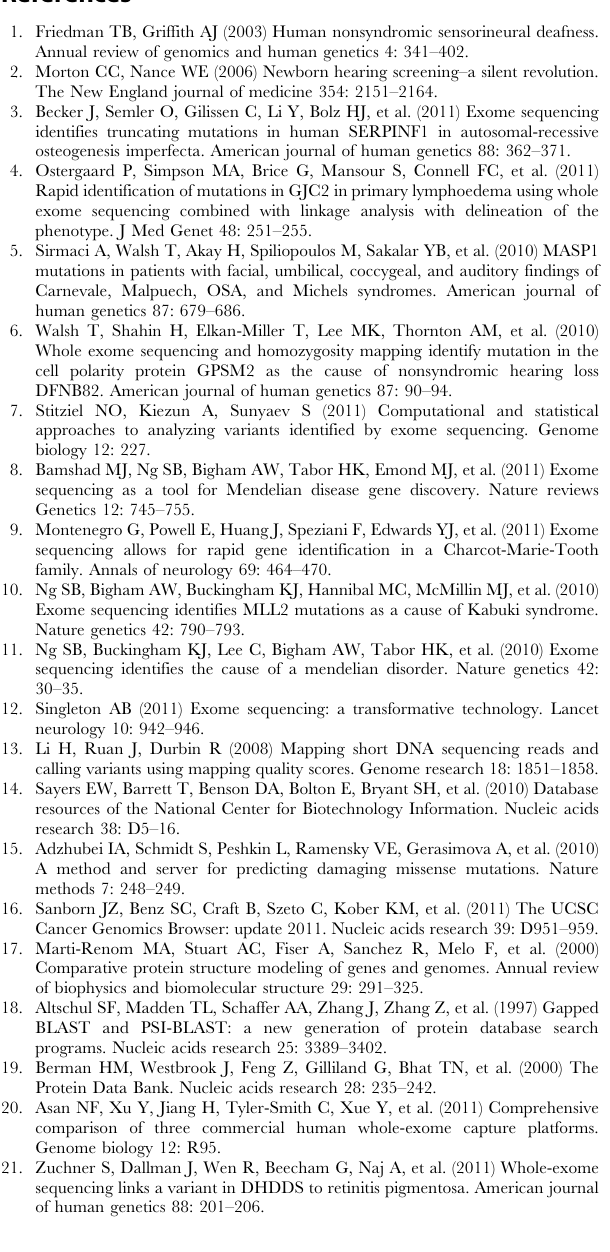
Figure S1 Coverage and read depth of five autozygous